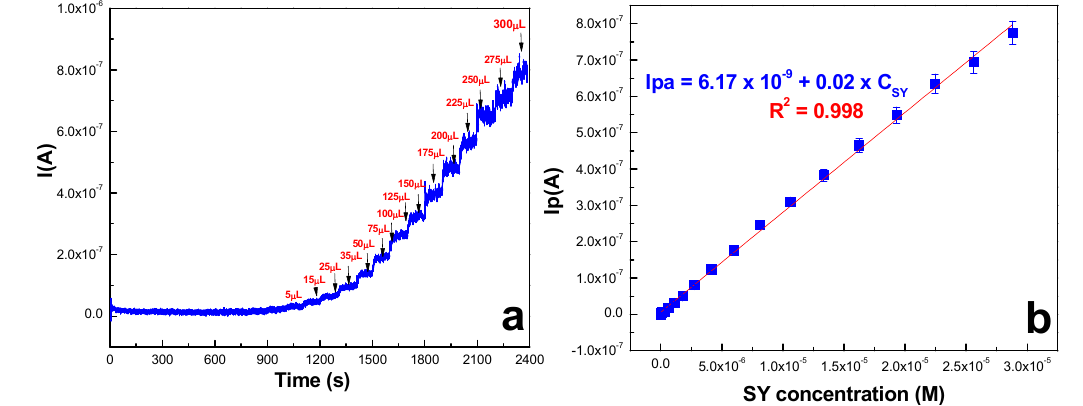
Figure 6. ( a ) Amperometric curves recorded with GR-exf/GC (+0.75 V applied potential) in pH 6 supporting electrolyte, after the addition of SY from 10 −4 M stock solution; the SY concentration range was 0.028–30 µ M; ( b ) the corresponding calibration plot obtained with background subtracted